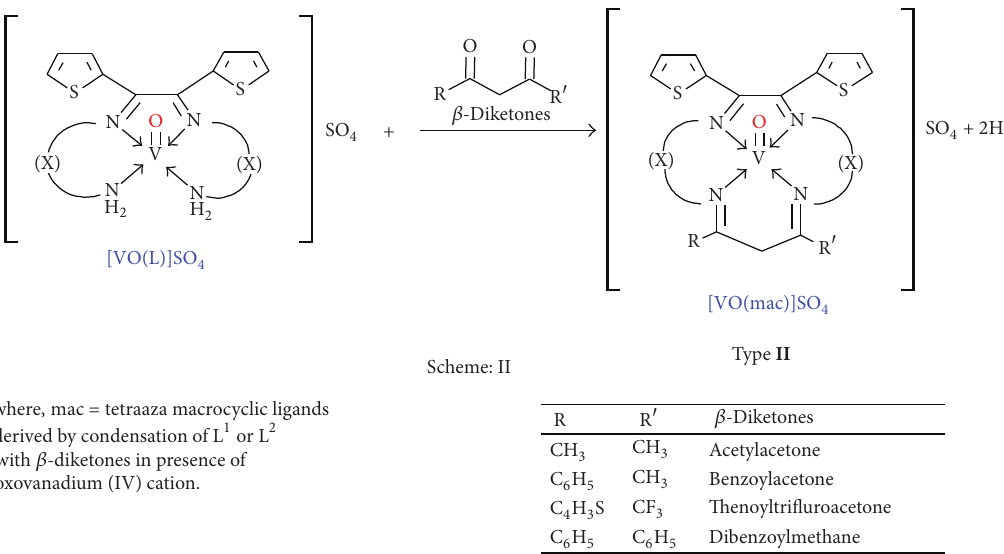
F 1: In situ preparation of macrocyclic complexes of